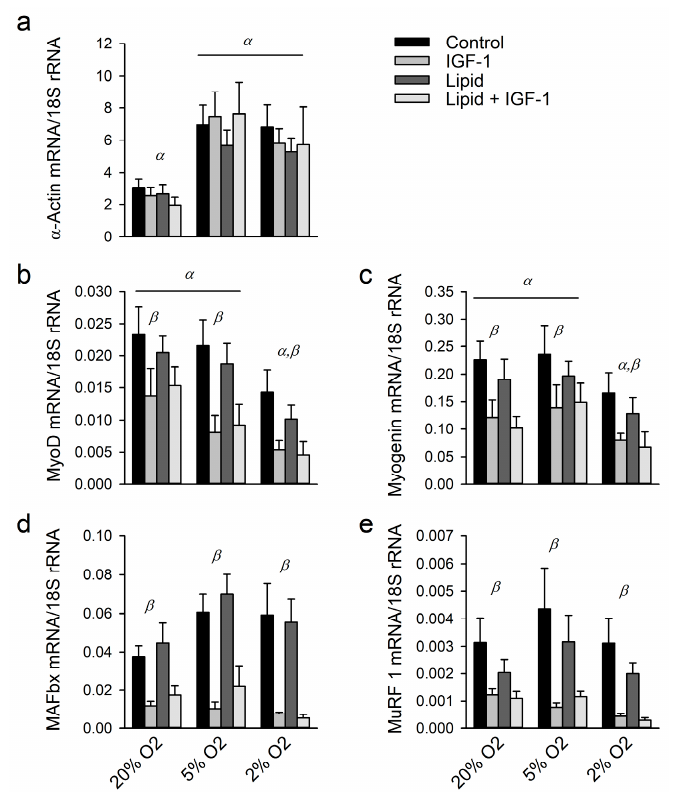
Figure 2. Regulators of protein synthesis are decreased under hypoxia and following IGF-1 supplementation, whereas regulators of protein synthesis are only slightly increased under hypoxia: ( a ) mRNA expression levels of α -actin under different oxygen tensions, with and without 24 h supplementation of IGF-1 and lipid; ( b , c ) mRNA expression levels of differentiation markers MyoD and myogenin; and ( d , e ) mRNA expression levels of protein degradation markers Muscle Atrophy F-box (MAFbx) and Muscle RING finger 1 (MuRF1). Please note that the interaction for IGF-1 treatment with oxygen tension is not depicted. α : significant effect of oxygen tension compared to other O 2 tensions denoted with α ; β : significant overall effect of IGF-1 treatment; γ : significant overall effect of lipid supplementation. Although β and γ designate overall effects, symbols are placed above each oxygen tension for clarity. Values are given as mean ± SEM, n = 6.